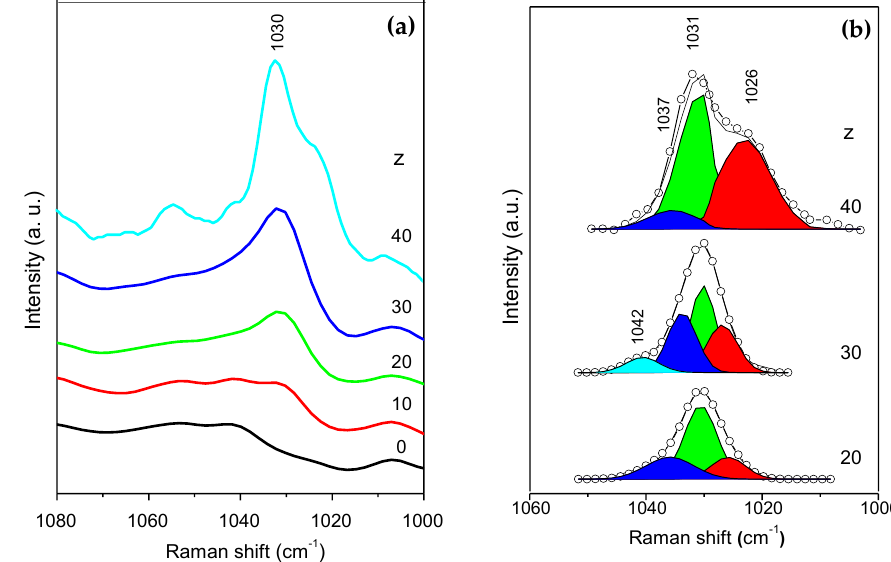
Figure 6. FT-Raman spectra ( a ) and curve-fitting results performed with the subtrated FT-Raman